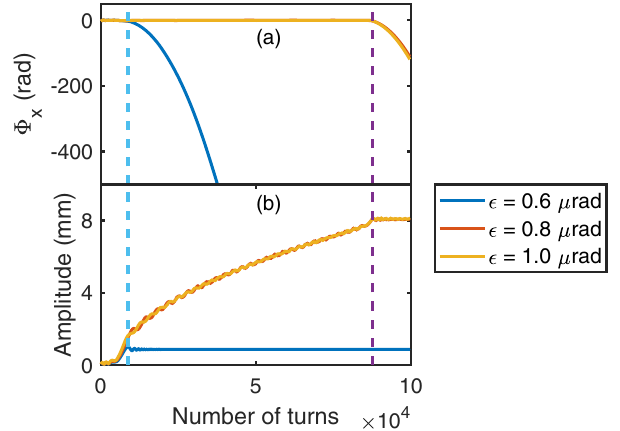
FIG. 2. (a) The difference of beam oscillation phase relative to the drive phase (phase mismatch, Φ x ), (b) beam oscillation amplitude, both as functions of the number of turns. The drive amplitudes are ϵ ¼ 0 . 6 , 0.8, and 1 . 0 μ rad,